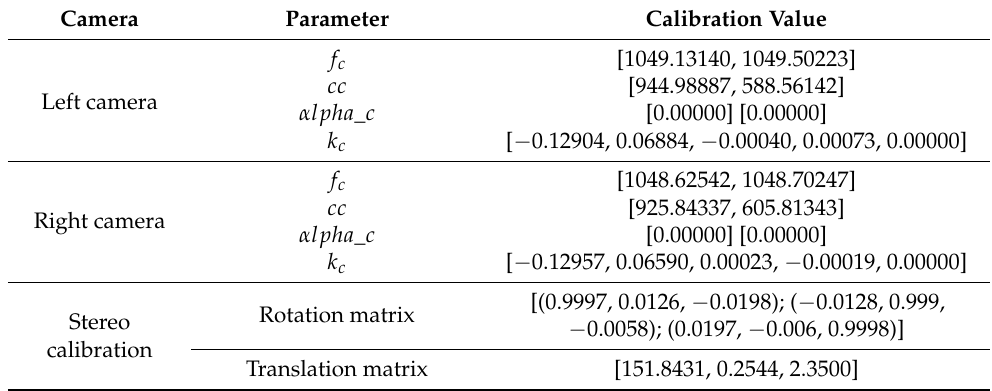
Table 1. Binocular camera calibration results.